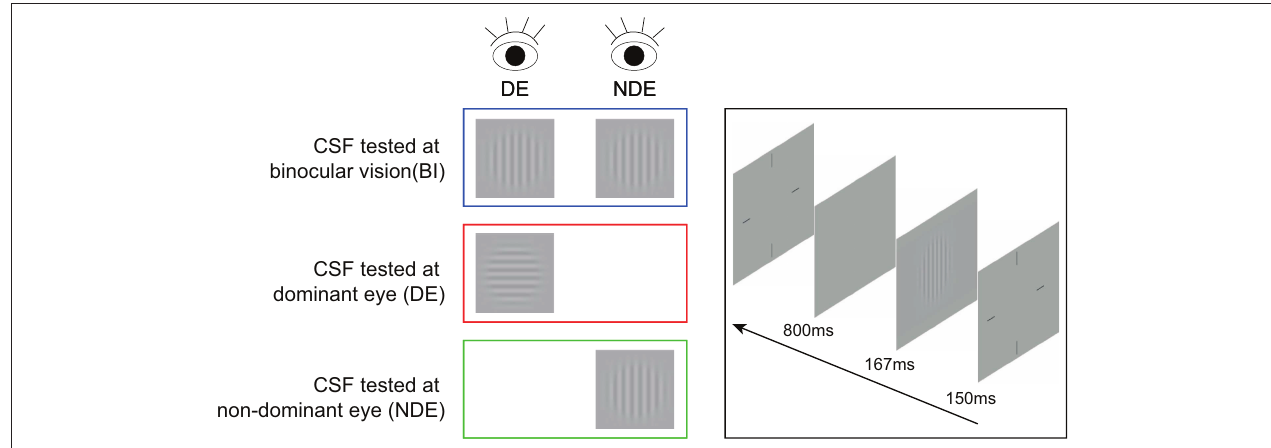
FIGURE 1 | An illustration of contrast sensitivity test. A sinusoidal grating stimulus in vertical or horizontal orientation was presented to each or both eyes for the measurement of contrast sensitivity. DE, dominant eye; NDE, non-dominant eye; CSF, contrast sensitivity function.